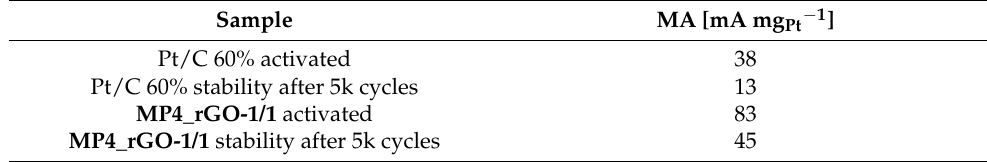
Figure 5. Electrochemical activity of the sample MP4_rGO-1/1 and Pt/C 60% as reference: ( a ) ob- tained linear sweep voltammetry at 10 mV s –1 sweep rate after the activation and after 5k cycles; ( b ) calculated mass-specific activity at 0.9 V after activation and after 5k cycles. Table 3. Mass-specific activity at 0.9 V of the sample MP4_rGO-1/1 after activation and after 5k cycles.